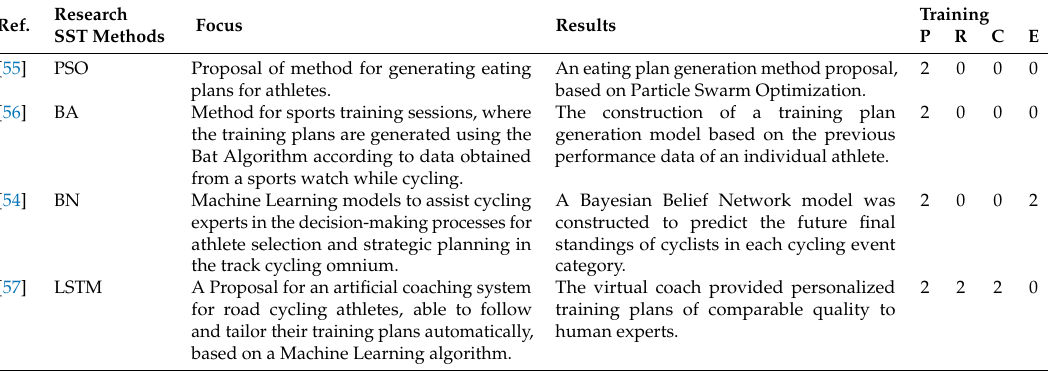
Table 6. Identified studies in the domain of